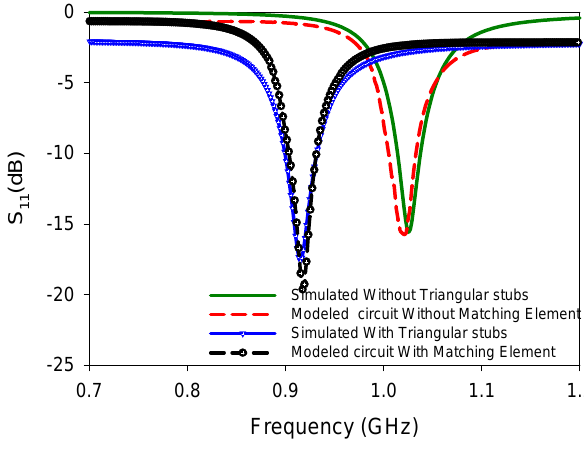
Figure 1: Structural configuration of the proposed RFID Tag antenna.